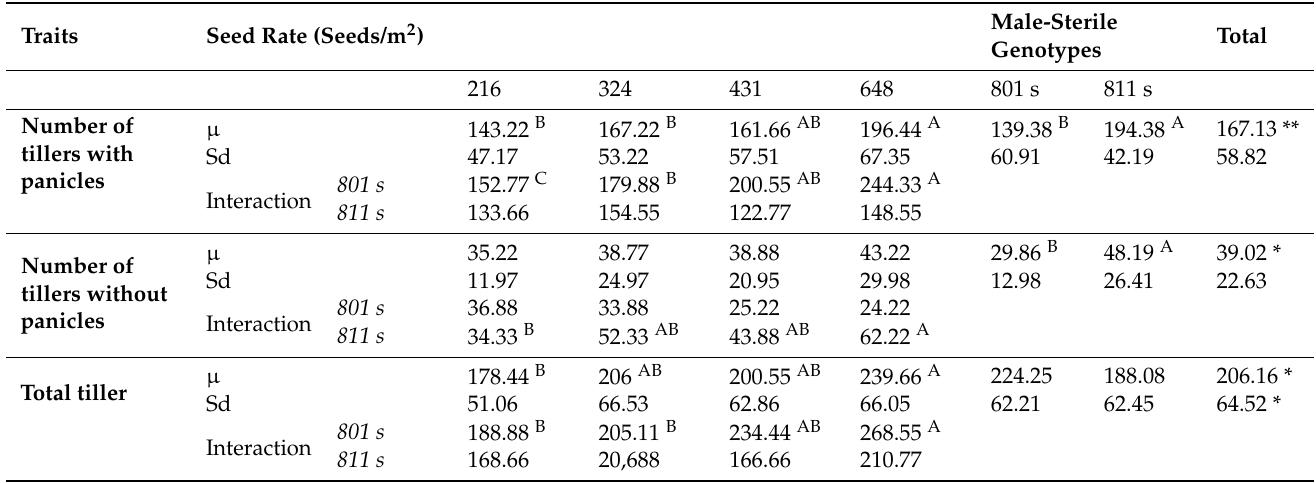
Table 3. Effect of seed rate and male-sterile genotypes on the number of tillers that produced panicles, number of tillers without panicles, and total tillers from year